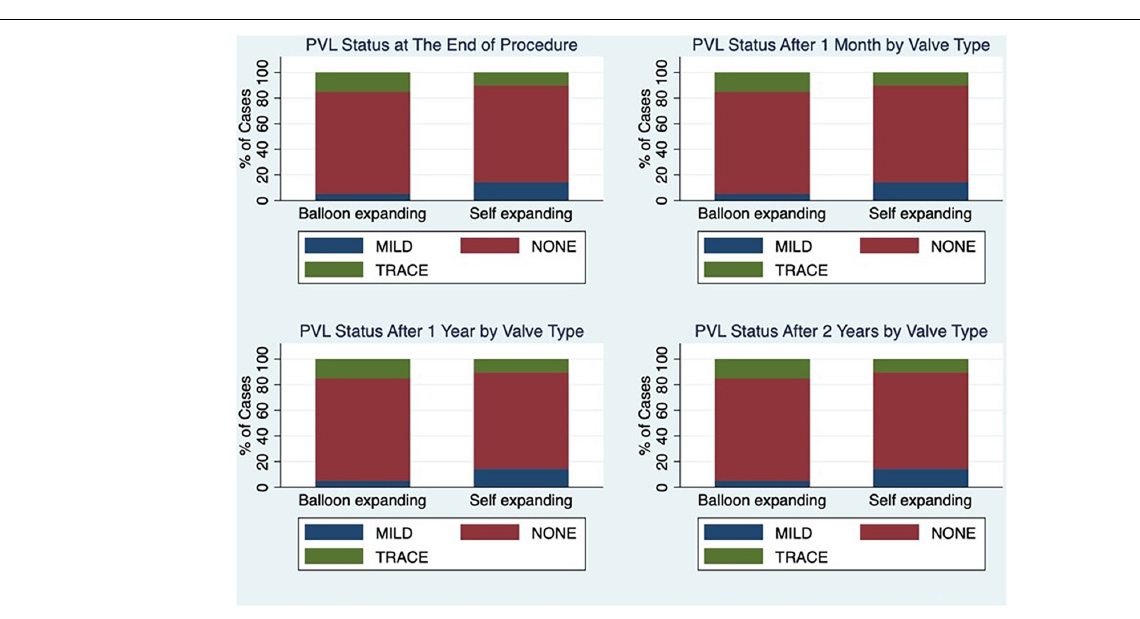
FIGURE 2 | Pair wise comparison of average valve area over 2 years after